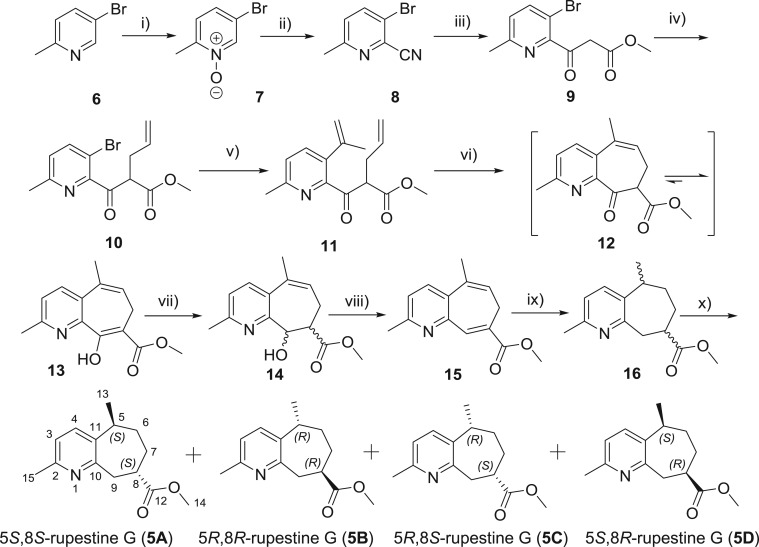
Synthesis of rupestine G and its epimers. Reagents and conditions: (i) m-CPBA, CH2Cl2, r.t., overnight, 92.7%; (ii) trimethylsilyl cyanide, triethylamine, MeCN, reflux, 12 h, 85.1%; (iii) a. ZnCl2, potassium methyl malonate, N,N-diisopropylethylamine, 1,2-dichloroethane, reflux, 16 h; b. 6N HCl, reflux,1 h, 82.1%; (iv) 3-bromopropene, EtONa, EtOH, r.t., overnight, 97.3%; (v) isopropenylboronic acid pinacol ester, Pd(Ph3P)4, 1,4-dioxane/H2O (v/v = 3:1), reflux, 3 h, 91.8%; (vi) Grubbs II, CH2Cl2, reflux, 12 h, 53.3%; (vii) NaBH4, MeOH, r.t., 1 h, 77.5%; (viii) MsCl, pyridine, 60°C, 3 h, 86.6%; ix) Pd/C, H2,MeOH, r.t., 5 h, 91.4%; (x) isolation by preparative HPLC, hexane/EtOH (v/v = 98:2).